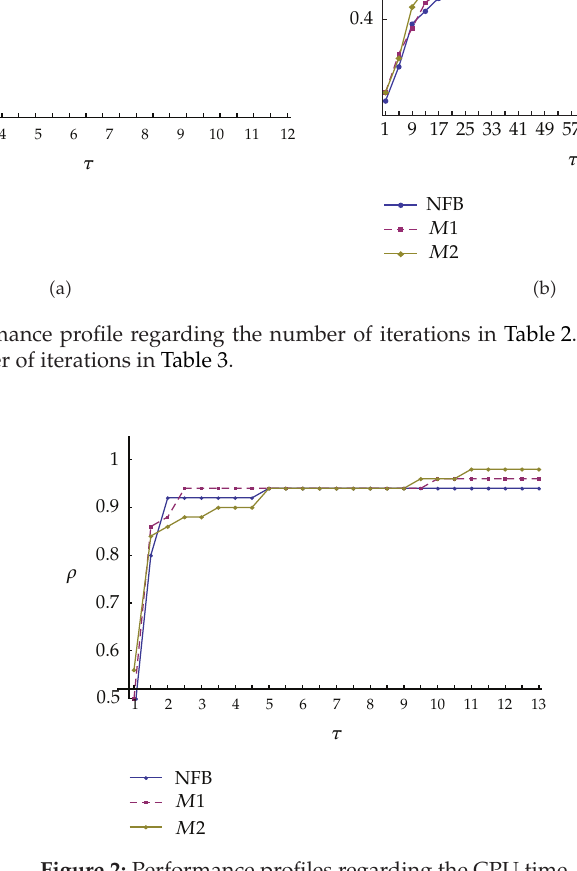
Figure 2: Performance profiles regarding the CPU